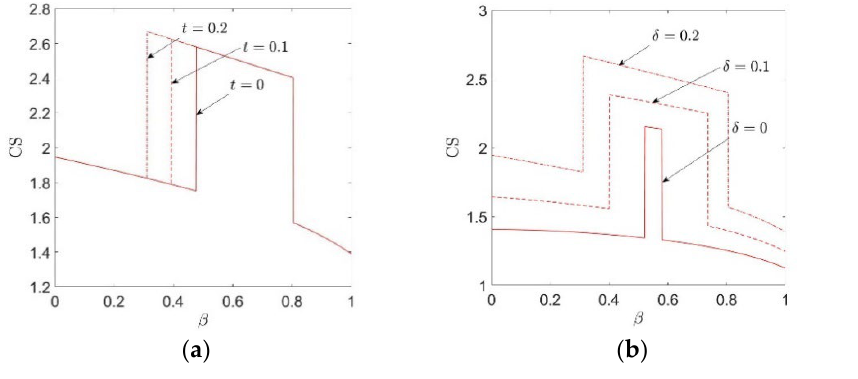
and ( a ) ( b ) ( c ) on CS. 𝛽𝛽 𝑡𝑡 𝛿𝛿 𝐴𝐴